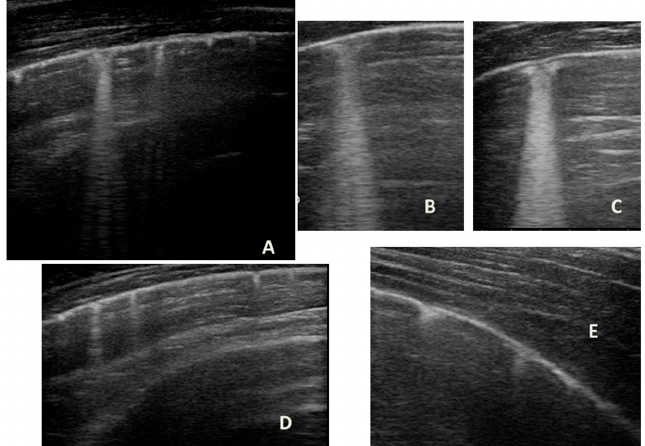
Figure 9. Grayscale lung ultrasound examination shows a picture of sonographic interstitial syn- drome (SIS) represented by: ( A ): irregularity of the pleural line, short vertical artifacts, and long vertical artifacts unevenly distributed bilaterally; ( B , C ): irregularity of the pleural line, sub-centimeter consolidations associated with long confluent vertical artifacts located mainly in the right lung fields, mainly in the mid-apical area; ( D , E ): short vertical artifacts with pleural line irregularities unevenly distributed